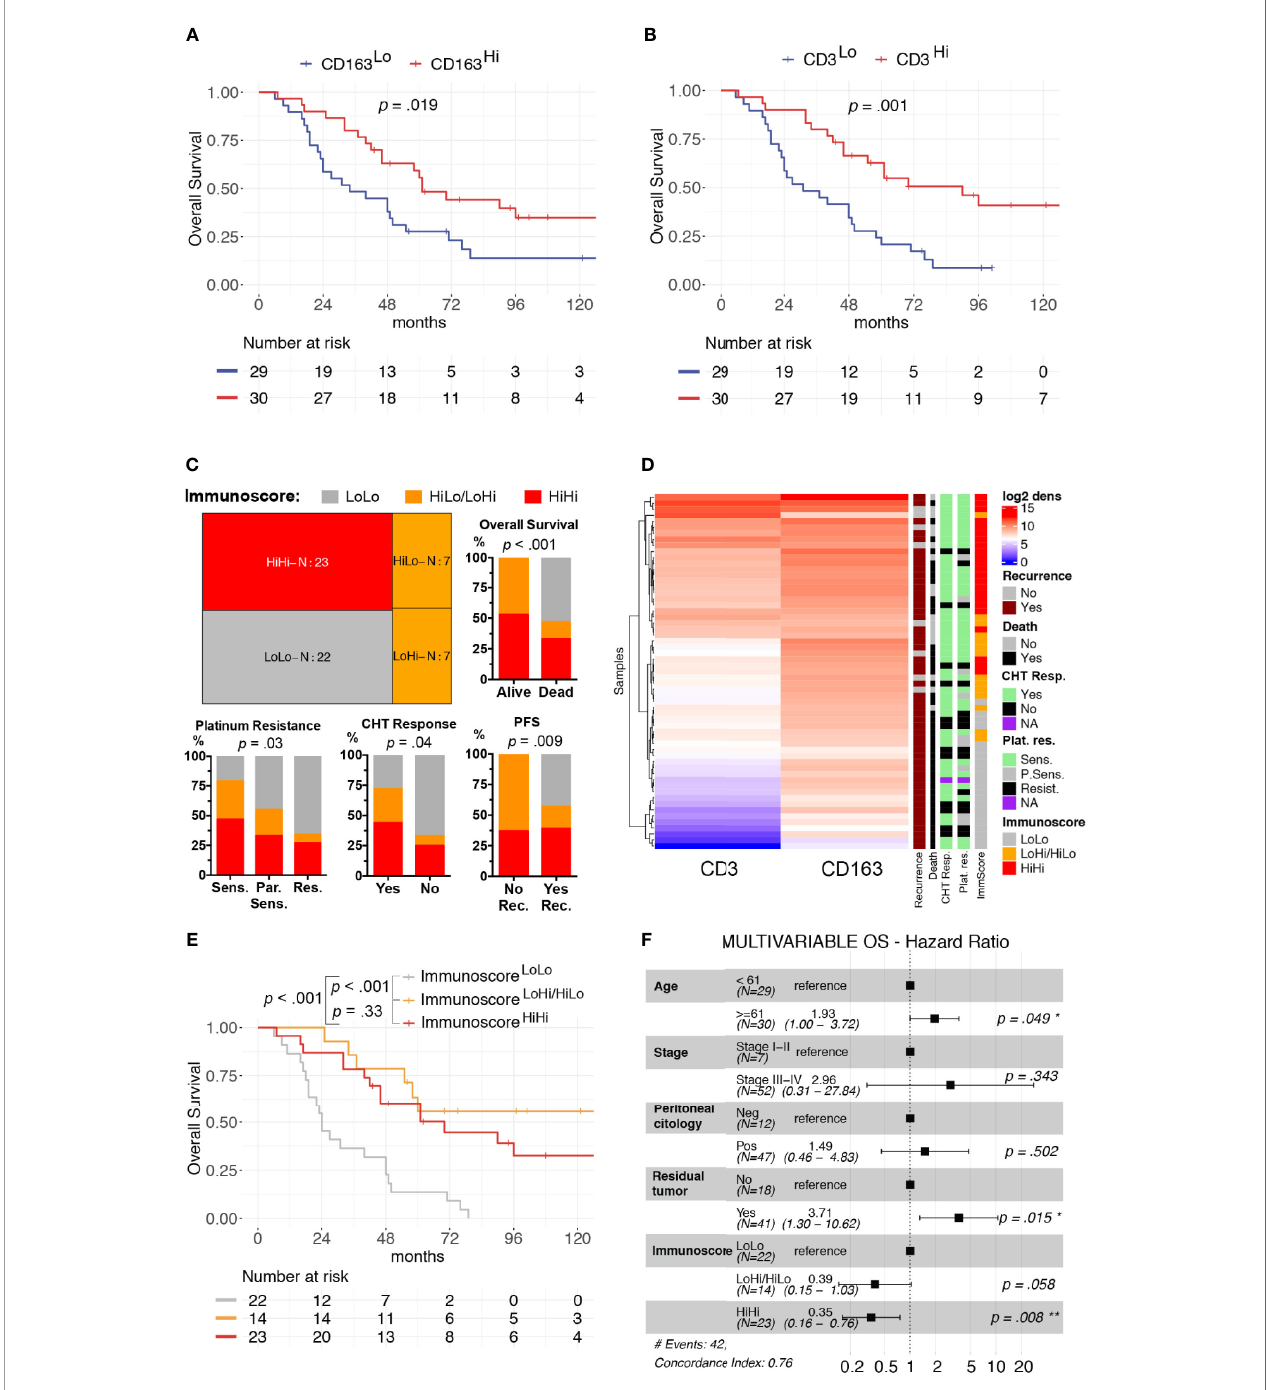
FIGURE 2 | Clinical signi fi cance of CD3 + T-cells and CD163 + TAMs density in HGSC. Univariable overall survival estimates (Kaplan – Meier method) according to CD3 + T-cells (A) and CD163 + TAMs (B) densities; p-values estimated with log-rank test. Treemap showing subgroup composition based on immunoscore and results of association analysis between immunoscore and chemotherapy response (CHT resp.), platinum resistance (Plat. Res.) and survival events (Death or Recurrence) (C) . Heatmap of unsupervised hierarchical clustering by Euclidean distance of log 2 CD3 + T-cells and log 2 CD163 + TAMs densities, each row represents a patient (D) . Univariable overall survival estimate (Kaplan – Meier method) of immunoscore classes (E) , pairwise comparisons p-values adjusted with FDR. Forest-plot of multivariable overall survival analysis (F) . Cut-offs for CD3 Hi and CD163 Hi densities were set at median values for each distribution. *P < 0.05; **P <